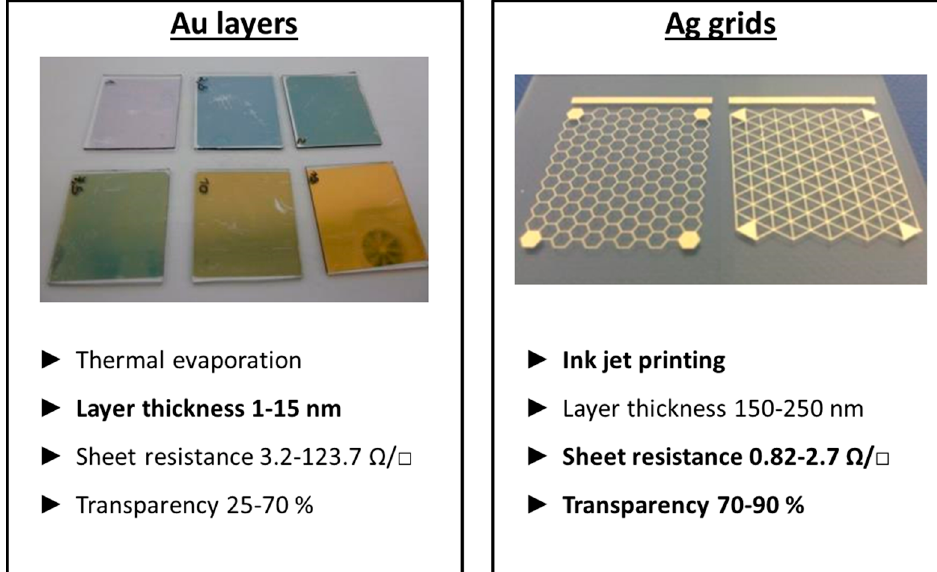
Figure 5. The transparent top electrode can be deposited by applying a full covering Au layer or by inkjet printing Ag grids.